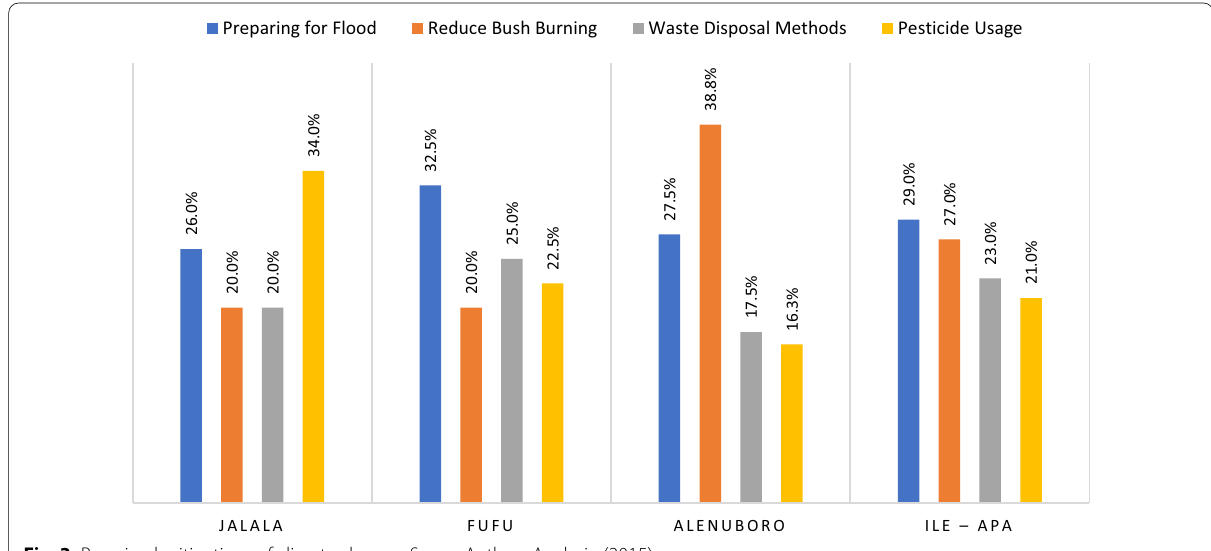
Fig. 3 Perceived mitigations of climate change Source Authors Analysis, (2015)